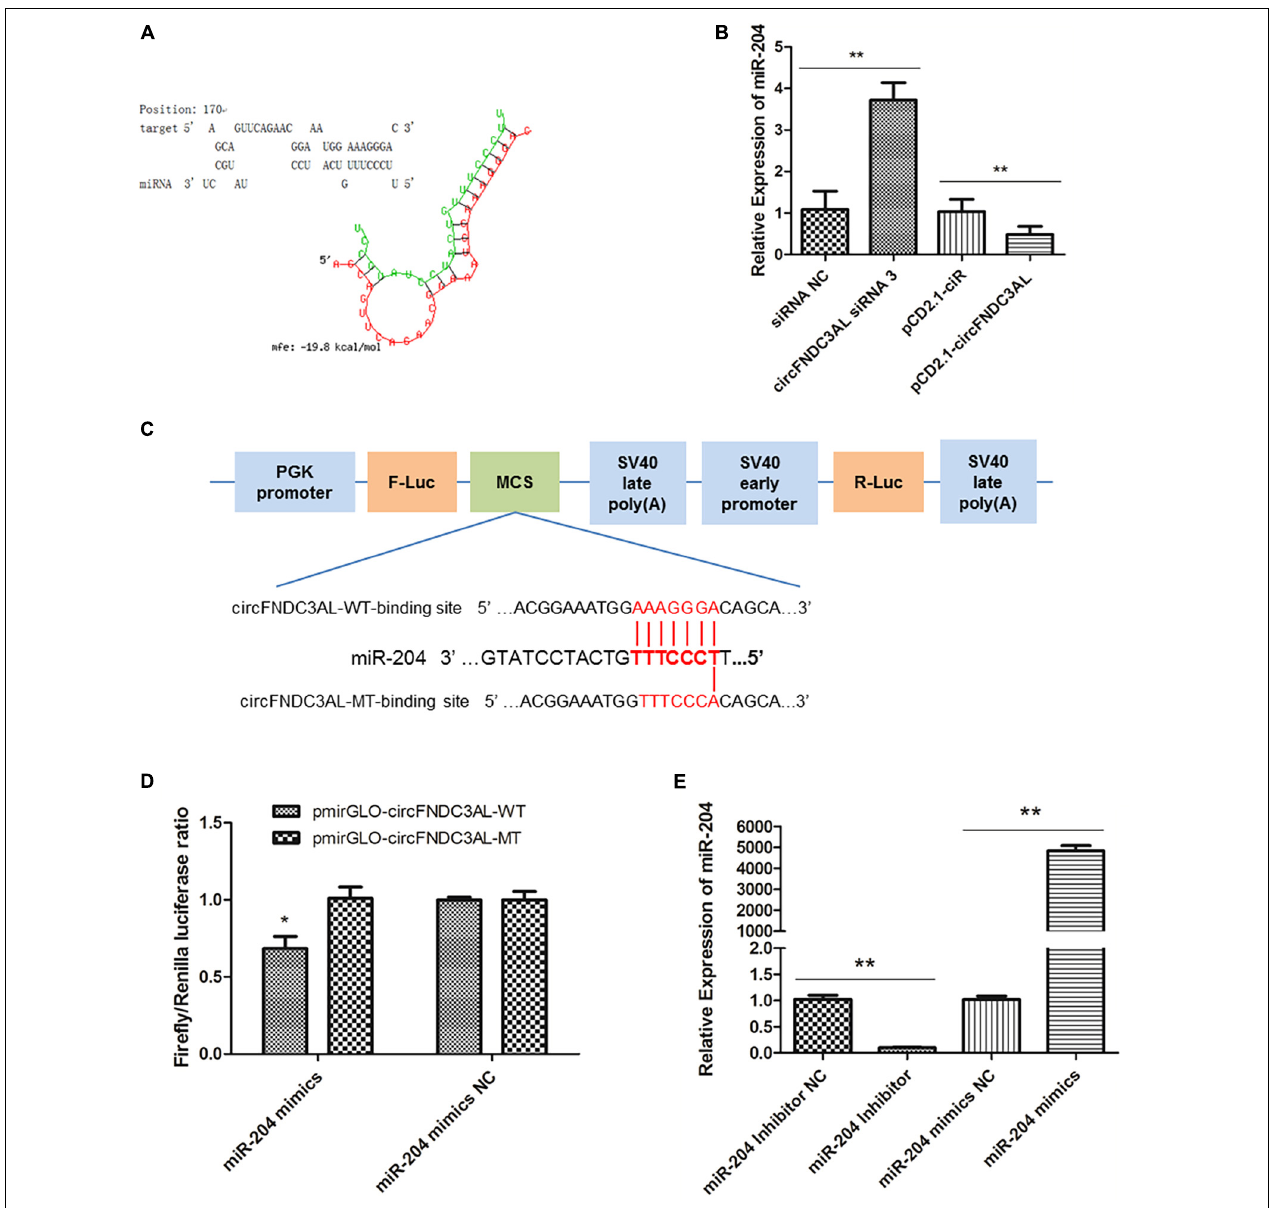
FIGURE 4 | circFNDC3AL could bind with miR-204. (A) Target site where miR-204 binds to circFNDC3AL was predicted using RNAhybrid software. (B) Expression levels of miR-204 were determined using qPCR after SMSCs were transfected with interfered or overexpressed circFNDC3AL. (C) Schematic diagram of wild type or mutant type of miR-204 target site designed for luciferase reporter assays. (D) Firefly/Renilla luciferase ratio was detected after DF-1 cells were transfected with pmirGLO-circFNDC3AL-WT/pmirGLO-circFNDC3AL-MT or miR-204 mimics/mimics NC. (E) Expression levels of miR-204 were determined using qPCR after SMSCs were transfected with miR-204 inhibitor or mimics. Values represent as means ± S.E.M. of three biological replicates. * P < 0.05; ** P < 0.01.